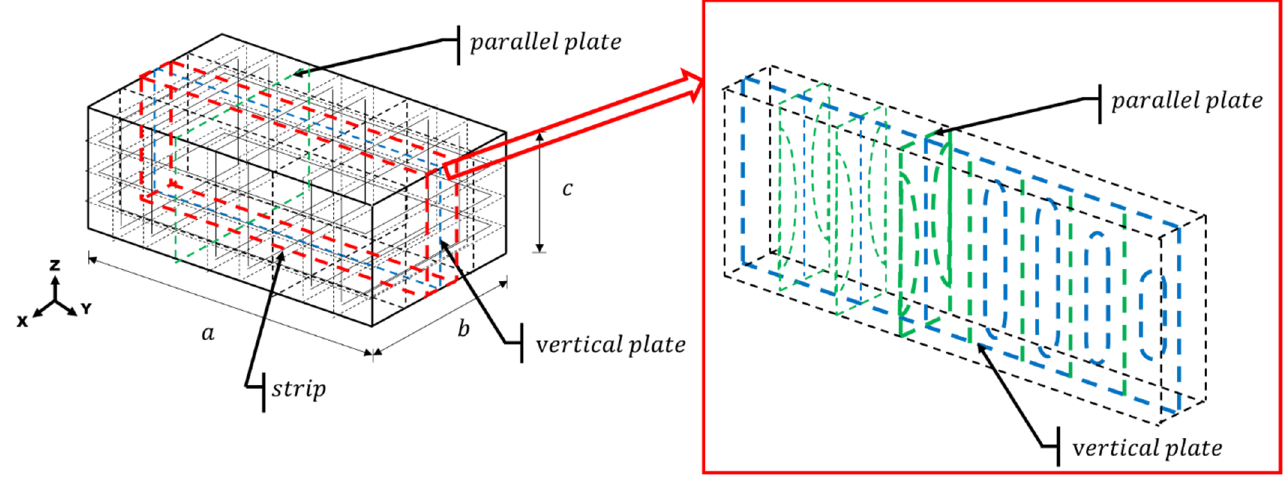
Figure 4. Strip model of plate-stiffened prismatic pressure vessel.